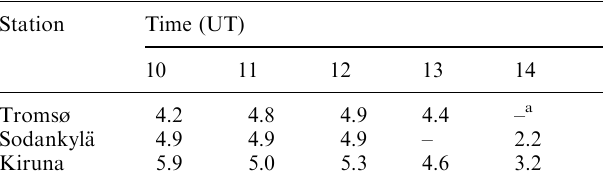
Table 1. F-region critical frequencies (MHz) observed by three ionosondes in the field of view of the Finland station of